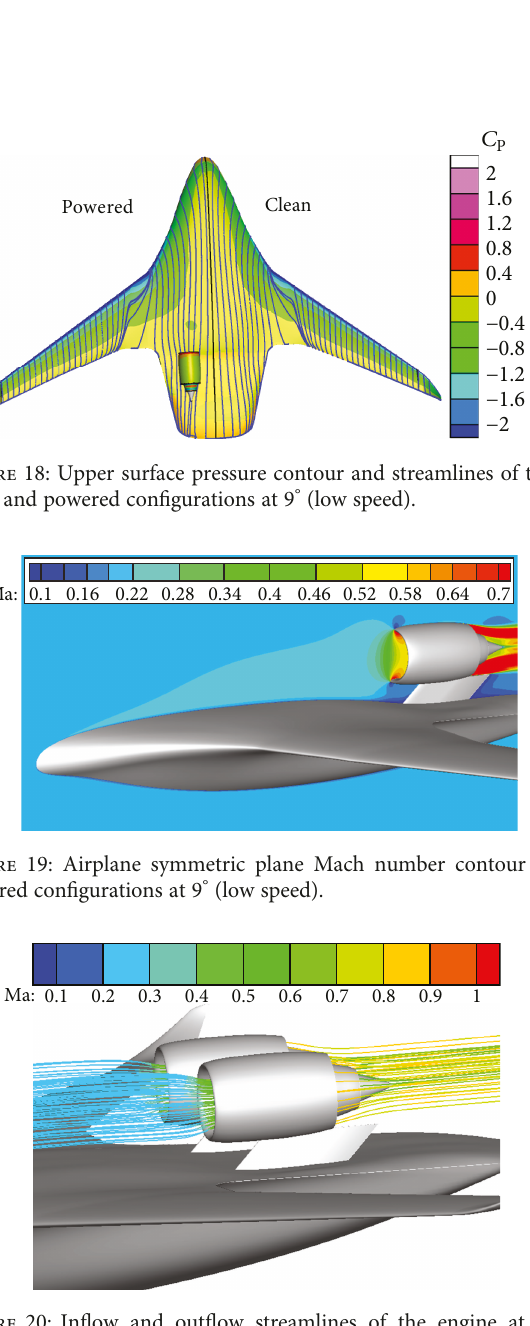
Figure 20: In fl ow and out fl ow streamlines of the engine at 9 ° (low speed).